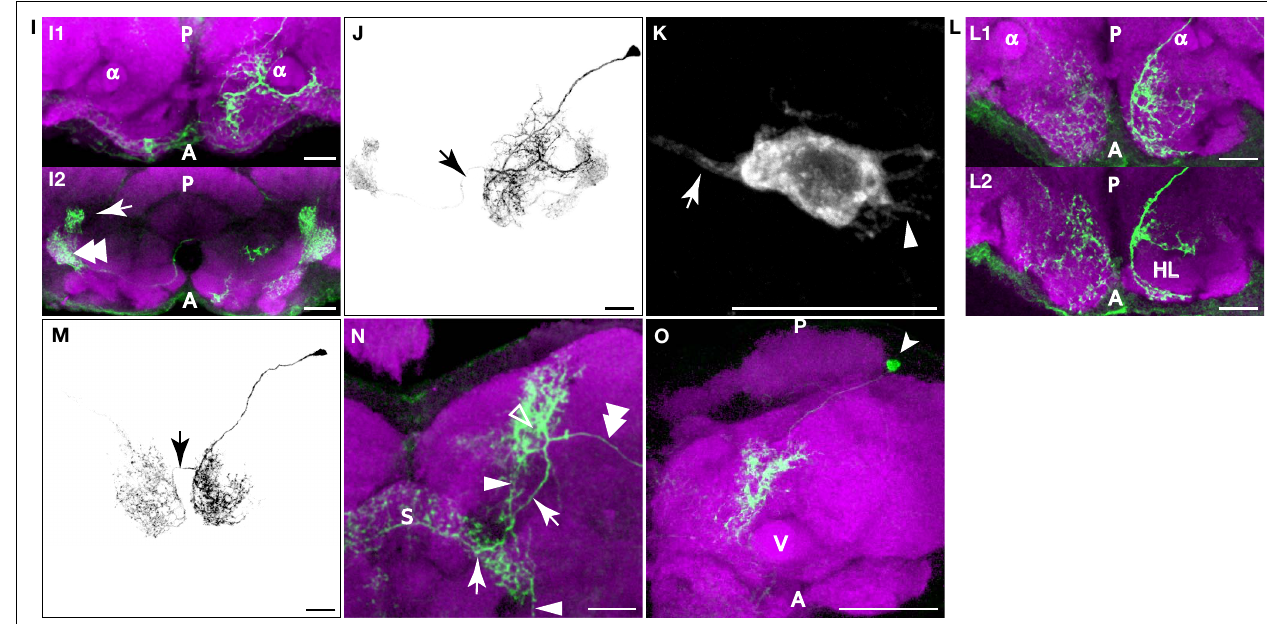
FIGURE 5 | PPL1 neurons innervate distinct areas of the mushroom body lobes. (I) Dorsal view at two levels of another PPL1 neuron innervating the heel. Panel (I1) shows the neurons at the dorsal/ventral level of the tips of the vertical lobes and panel (I2) shows the neuron at the level of the heel. Posterior (P) is up; anterior (A) is down. Panel (I1) shows that the more dorsal processes of this neuron ramify around the anterior surface of the vertical lobes before innervating the heel (double arrowhead in (I2) ) and the distal peduncle (arrow in (I2) ). (J) Entire track of the neuron in panel (I) . The neuron extends a process that branches extensively around the ipsilateral vertical lobe in the anterior protocerebrum, prior to innervating the ipsilateral heel and the distal peduncle. Arrow points to the fi ber providing innervation to the contralateral heel and peduncle. (K) Cell body of the PPL1 neuron shown in panel (F) . The arrow points to the primary neurite that projects to the mushroom bodies. The arrowhead points to short processes. (L) One type of PPL1 neuron innervates the anterior superior and inferior medial protocerebrum. (L1) Image from a dorsal perspective taken at a level near